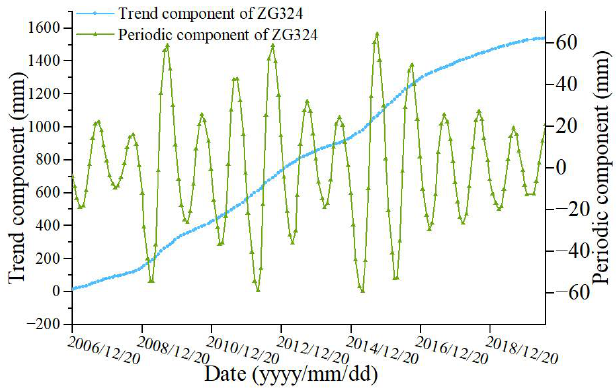
Figure 11. Decomposing results of the measured total displacement via VMD.